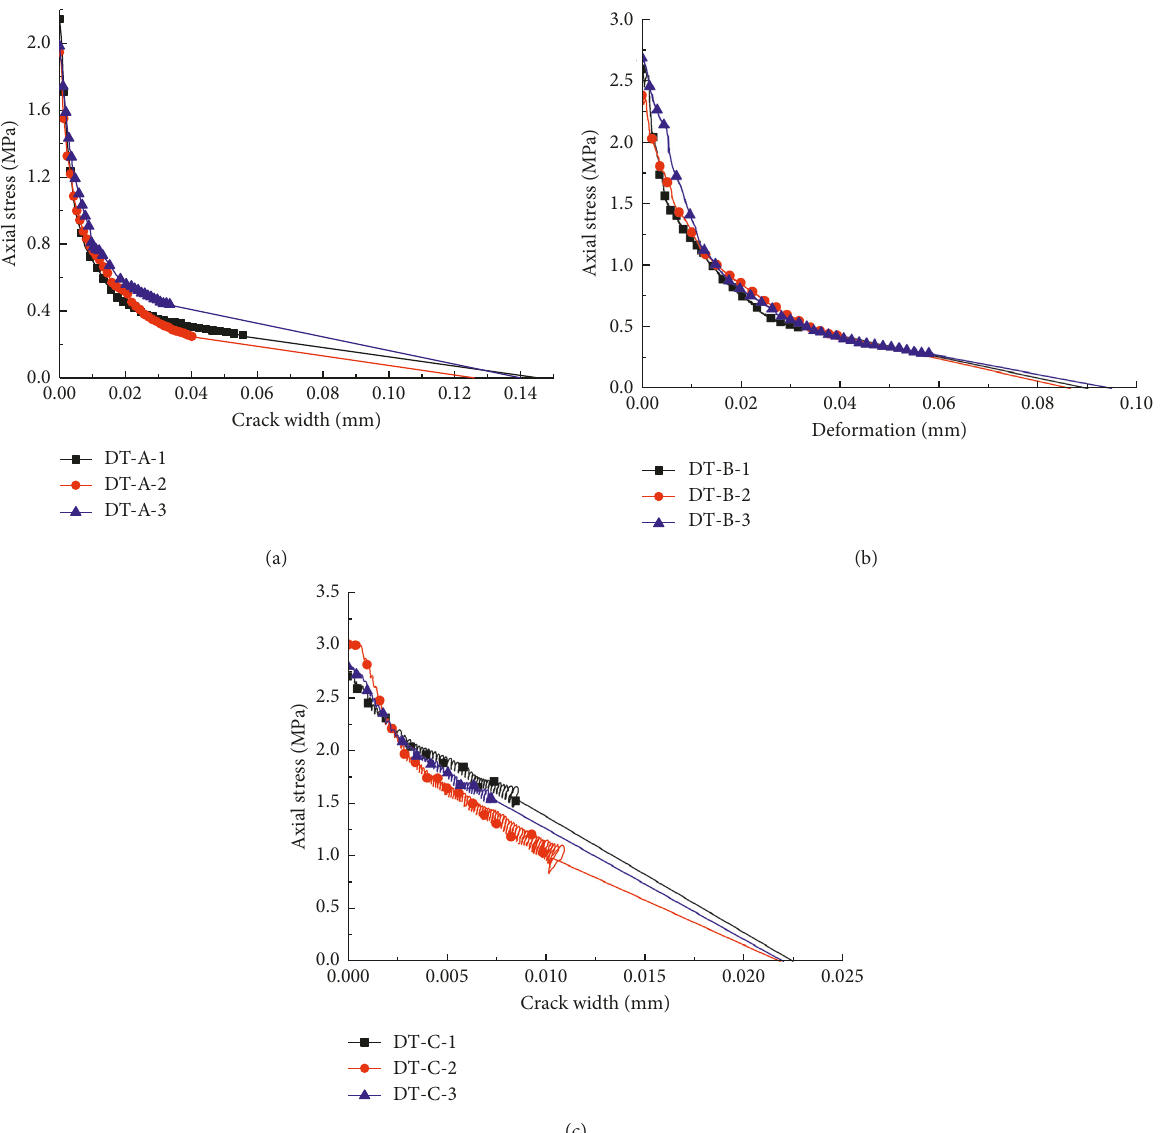
Figure 6: Axial-stress-crack-width curves under different strain rates ( σ − ω ) by experimental. (a) 10 − 6 s − 1 ; (b) 10 − 5 s − 1 ; (c) 10 − 4 s − 1 Table 1. During the process of axial tensile test, the overall deformation of the sample was measured by the extensom- eter, and the value of the elastic deformation and plastic deformation of the rock section and mortar section of each specimen was obtained by Equation (2)–Equation (5); the axial-stress-crack-width curves for different strain rates (10E-4, 10E-5, and 10E-6) were obtained, as shown in Figures 6(a)–6(c). As can be seen from these figures, along with increasing strain rate, the axial tensile strength of the rock- mortar interface increases and the maximum crack width varies from a concave-downward trend to a linearly de- creasing trend.